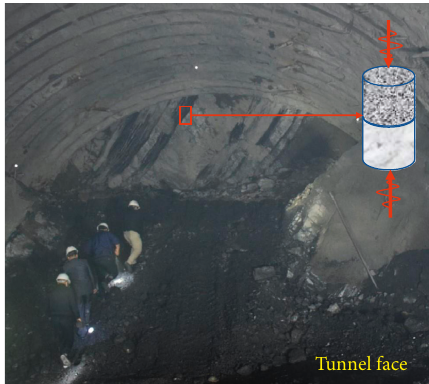
Figure 1: Photograph of composite rock in tunnel